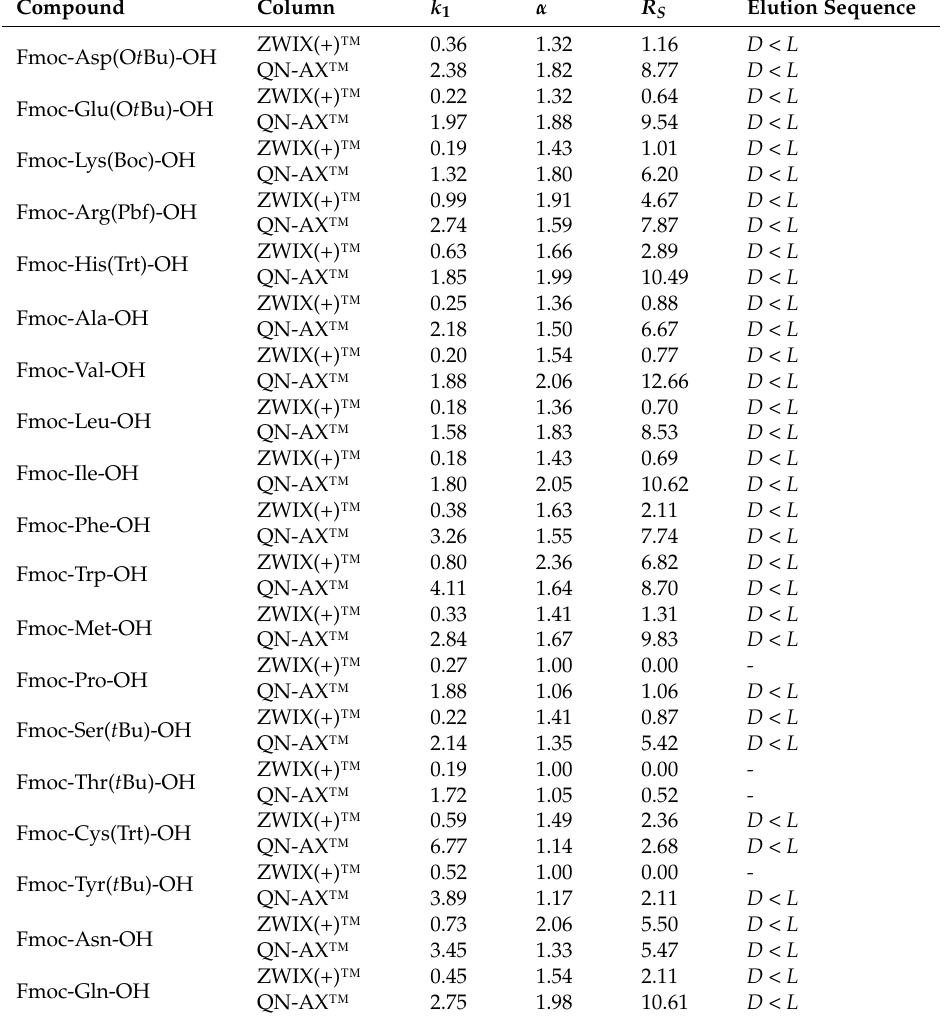
Table 1. Chromatographic data, retention factor ( k ), selectivity factor ( α ), resolution ( R S ) and elution sequence of N -Fmoc-protein amino acids on ZWIX(+)™ and QN-AX CSPs at liquid chromatographic